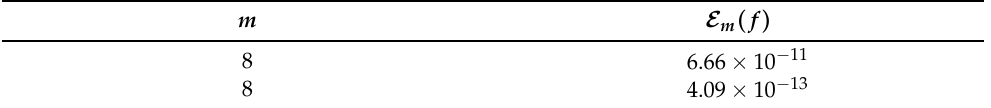
Table 3. Example 3: Errors in rational Gauss rules for the approximating of (27) with A a symmetric positive definite Toeplitz matrix. In the first row, the poles are α 1 = 0 of multiplicity two and α 2 = − 1/4 of multiplicity one. In the second row, the poles are allocated using (23) with α = − 1 and (cid:96) = 2. The pole α = − 1.1716 is of multiplicity two, and the pole α = − 6.8284 is of multiplicity one. 2 1